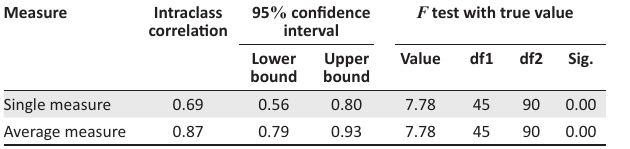
FIGURE 6: Bland–Altman plot showing the difference between the amplitude of accommodation at 6 m and 33 cm. The bold solid line represents the mean difference or bias.